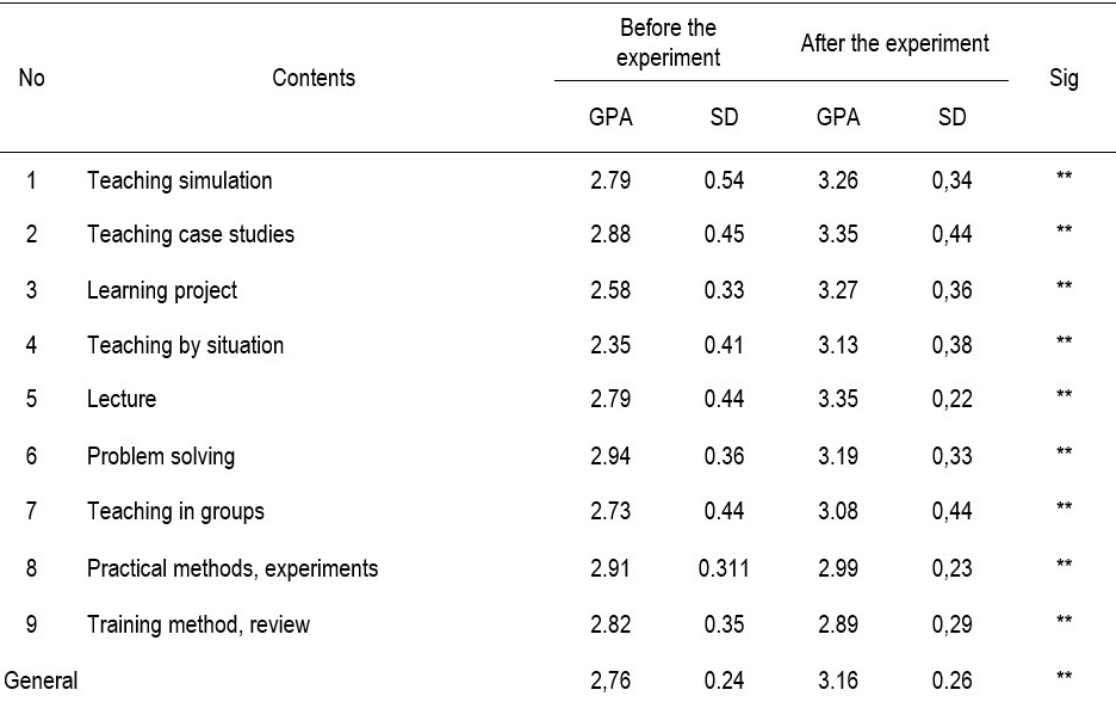
Skills of practicing teaching methods before and after